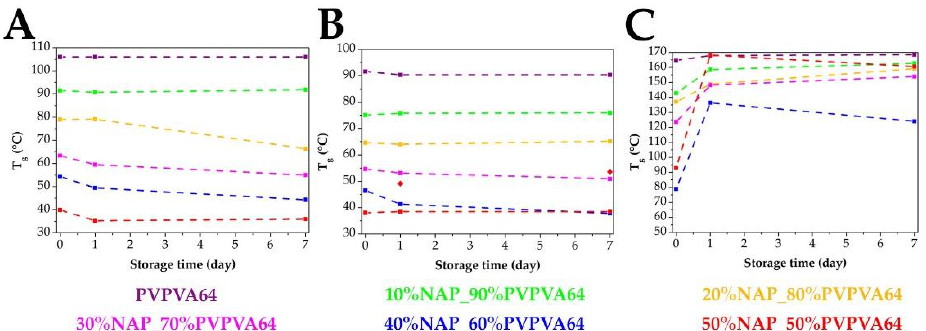
Figure 10. Changes of the T g values measured by MDSC ( A ), TSDC ( B ), and µTA ( C ) in the function of the storage time.